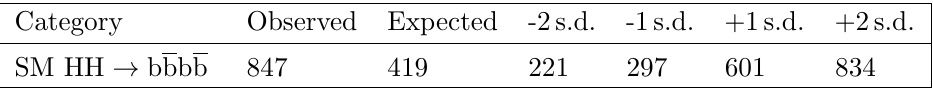
Figure 8 . Post-(cid:12)t distribution of M H model is applied by rescaling the weight of each event using the event yield ratio between corrected and uncorrected BDT distributions.